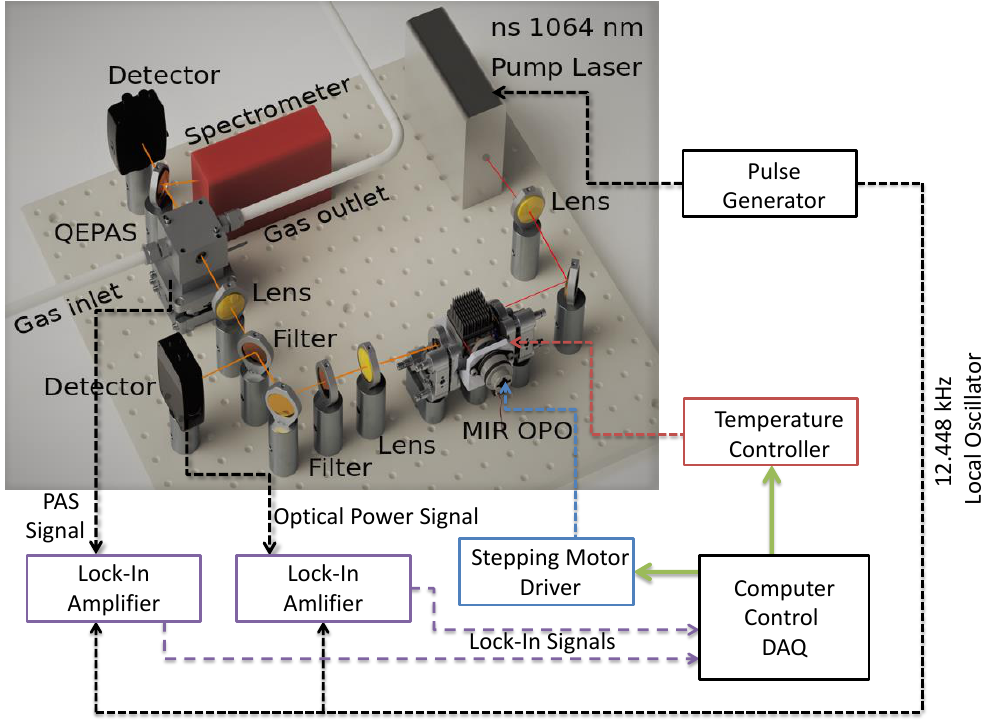
Figure 1. Schematics of the QEPAS sensor system with the MIR OPO and QEPAS cell (Thorlabs, ADM01) as the main